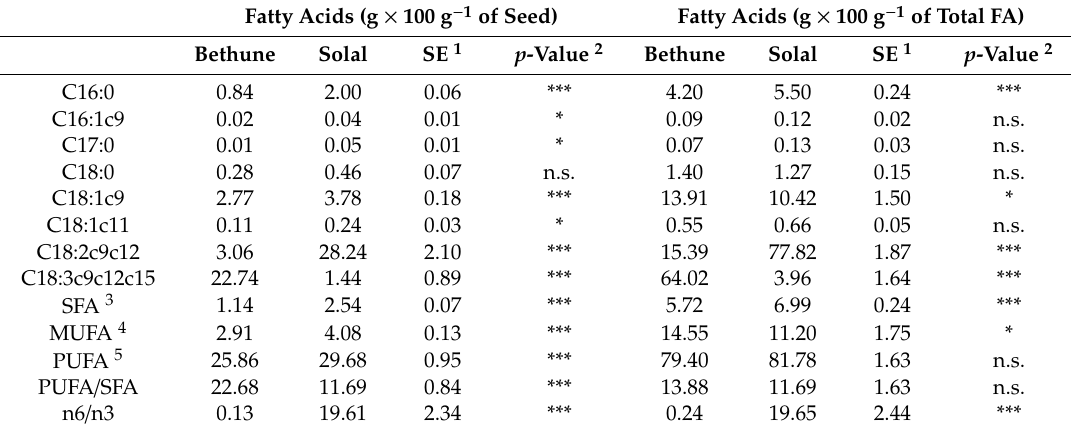
Table 3. Major fatty acid composition (expressed as g 100 g − 1 of seed and as g 100 g − 1 of total FA) of the two linseed varieties (Bethune and Solal).